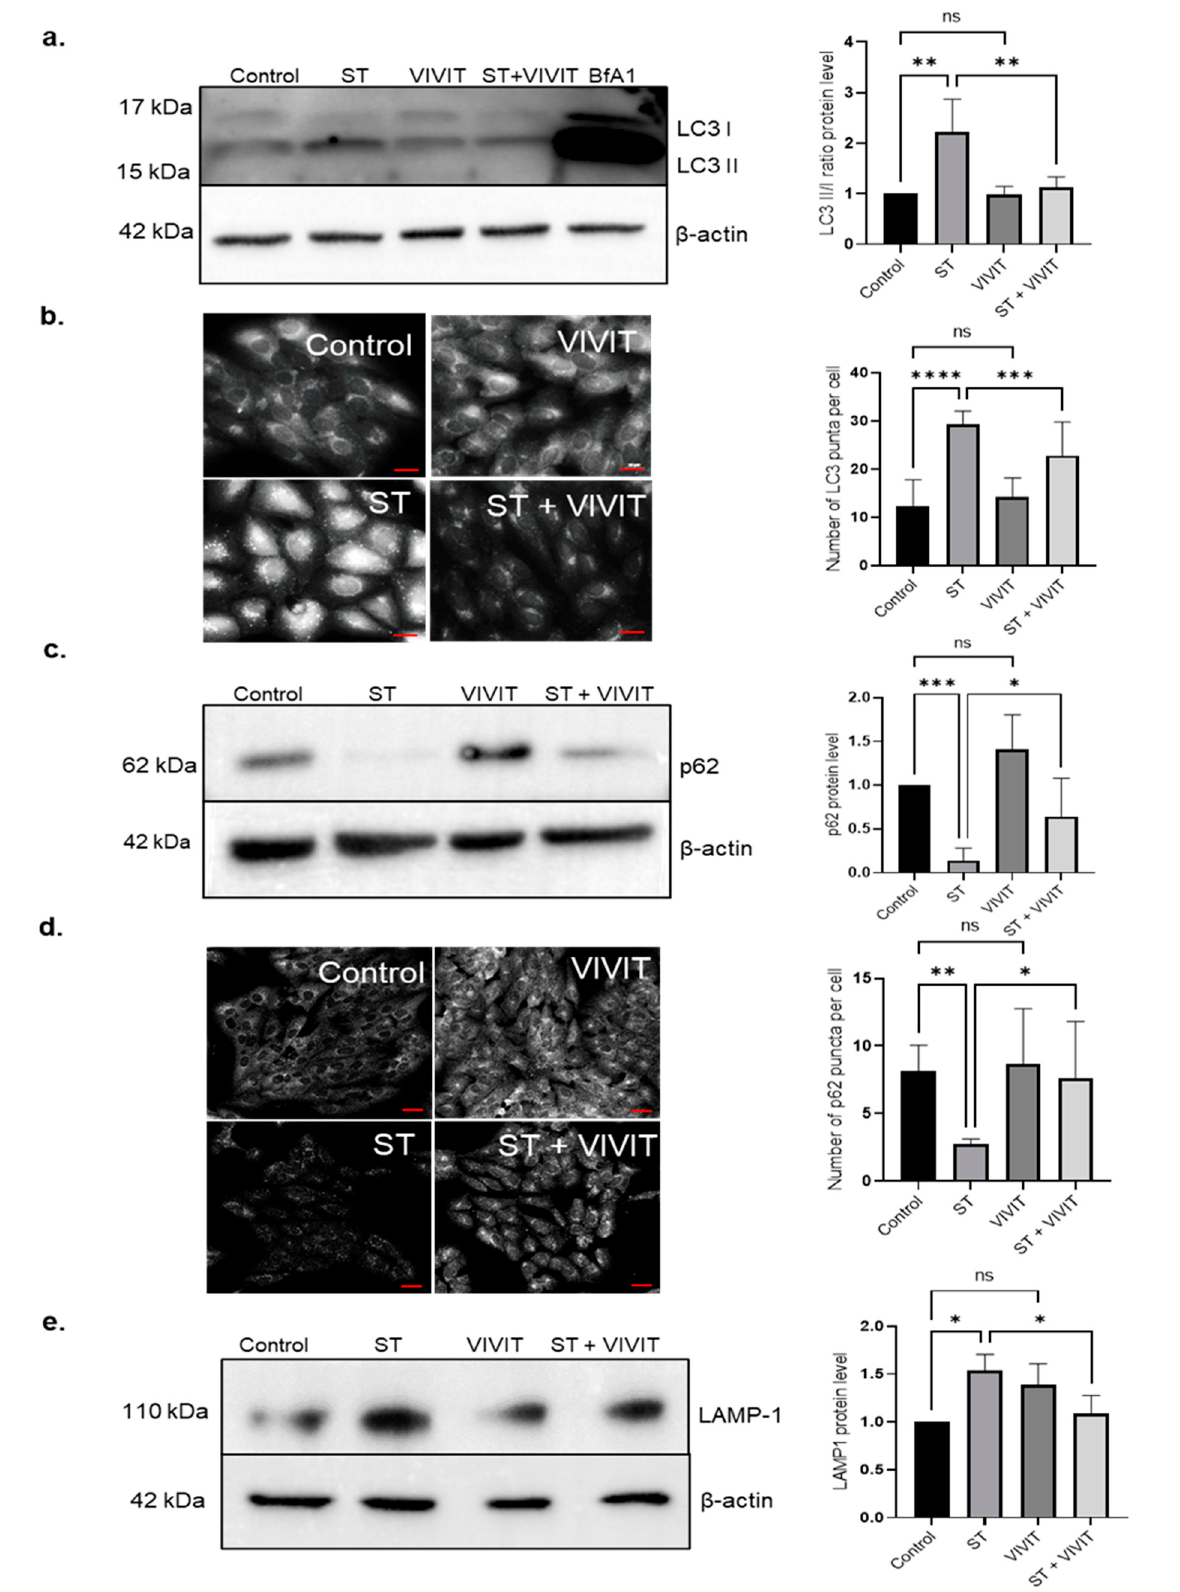
Figure 2. Inhibition of NFAT downregulates autophagy flux and lysosomal function. ( a ) Immunoblot analysis of LC3 expression in ARPE-19 cells subjected to nutrient deprivation and treatment with 20 µM VIVIT for 48 h. ( b ) The number of LC3 puncta was quantified by LC3 immunostaining of cells treated with 20 µM VIVIT and subjected to nutrient